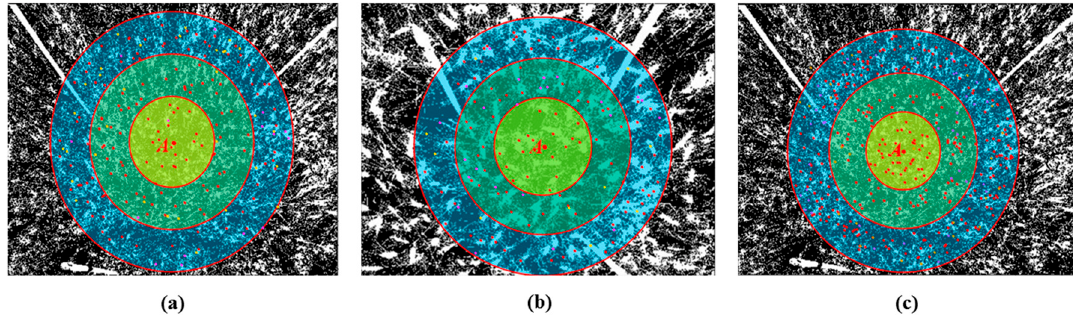
Figure 10. Segmentation accuracy within different radii upon using proposed method. The yellow, green, and blue areas indicate an observation radius of 0–0.25 m, 0.25–0.5 m, and 0.5–0.75 m. The point A is the ortho center of the image. ( a ) Observation range analysis in T 1 plot; ( b ) Observation range analysis in T 3 plot; ( c ) Observation range analysis in T 4 plot.